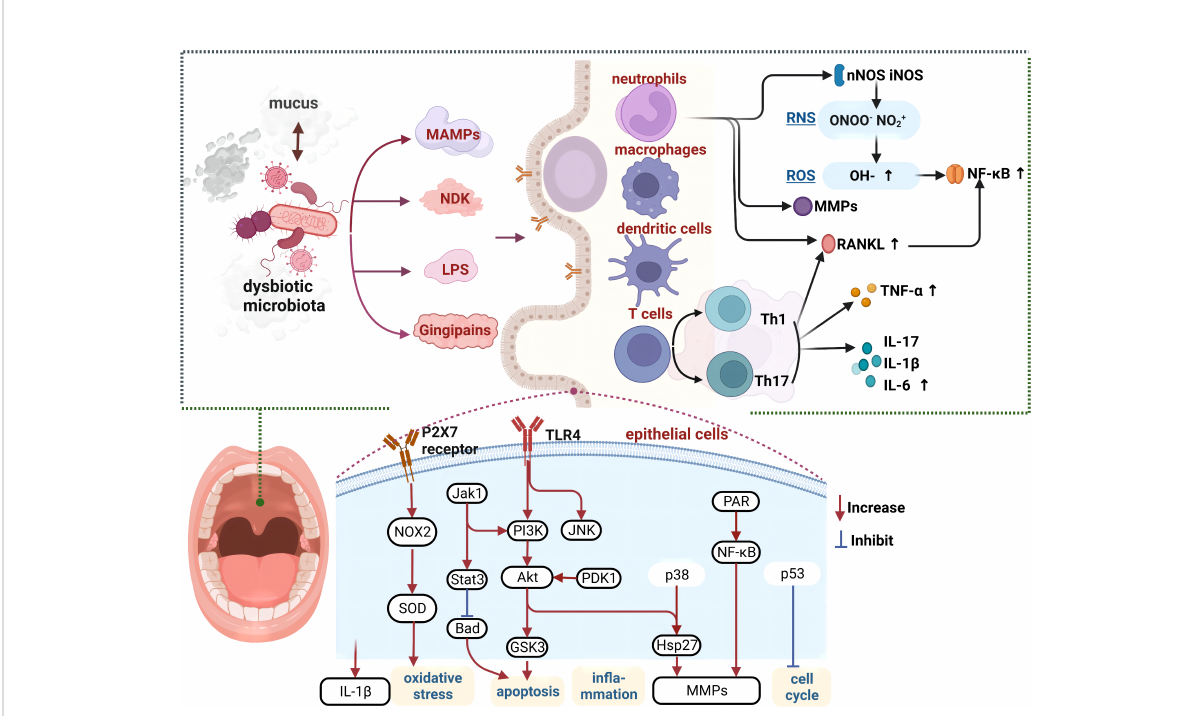
FIGURE 2 Crosstalk mechanisms between the oral microbiota and local tissues Crosstalk of the oral microbiota with saliva and oral epithelial tissues, causing epithelial cell apoptosis, immune cell proliferation, and in fl ammation, which may further exacerbate dysbiosis. Various cytokines act on vascular endothelial cells to facilitate the onset of cardiovascular disease. MAMPs, microbe-associated molecular patterns; NDK, nucleoside- diphosphate-kinases; LPS, lipopolysaccharide; TLR, toll-like receptors; MMPs, matrix metalloproteinases; ROS, reactive oxygen species; RNS, reactive nitrogen species; TNF- a , tumor necrosis factor- a ; MMPs, matrix metalloproteinases; Th, T helper; IL,